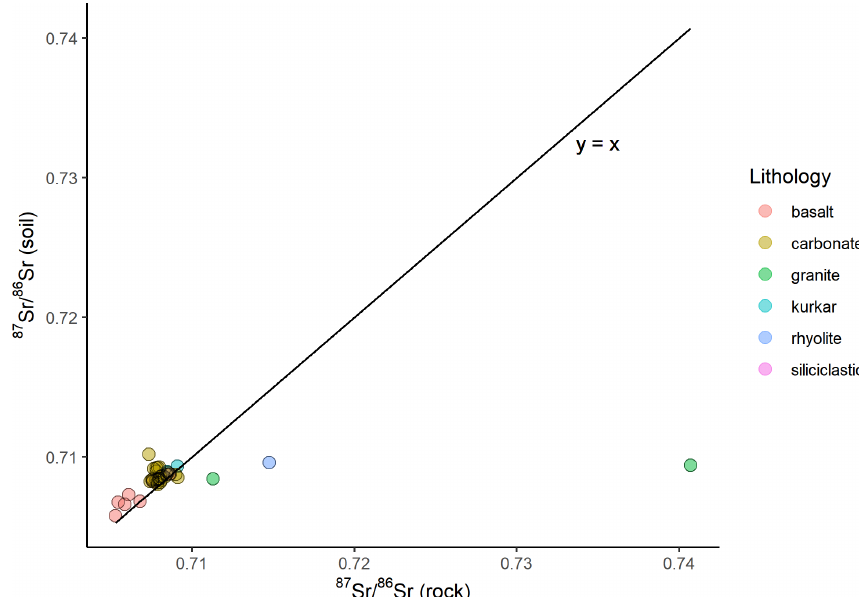
Figure 6. Bioavailable 87 Sr / 86 Sr of rock and 87 Sr / 86 Sr of soil samples collected from the same sample locations. Sample locations are grouped based on gross lithology observed in the field. Points which lie along the reference line ( y = x ) have the same 87 Sr / 86 Sr ratios for both soil and rock samples from the same sample site, while points above the line indicate a higher soil 87 Sr / 86 Sr ratio than rock, and points which lie below this line indicate a rock 87 Sr / 86 Sr ratio higher than the soil sample from the same site.